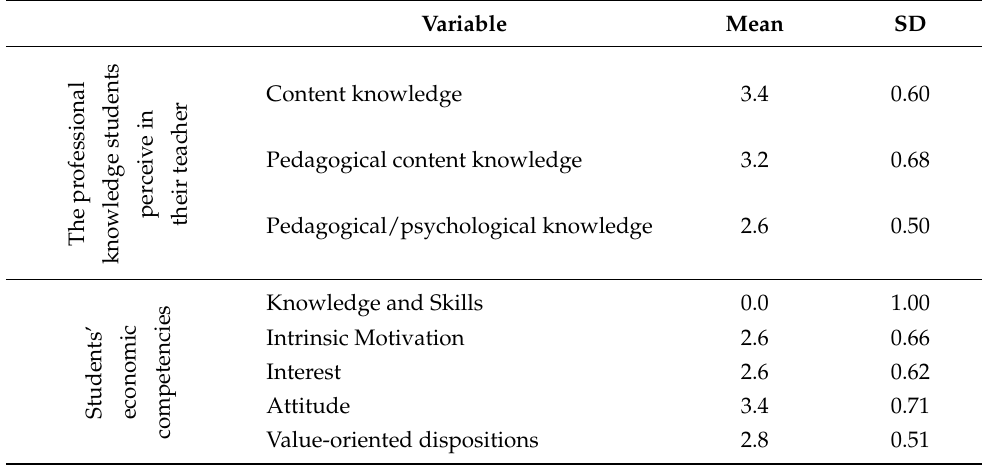
Table 6. Descriptive